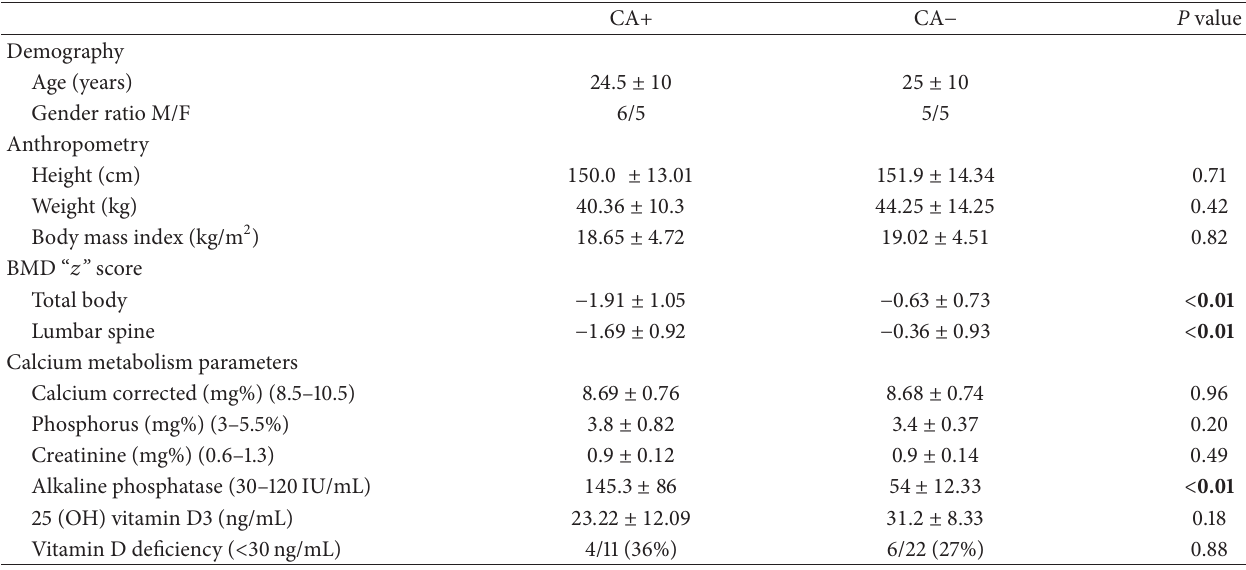
Table 6: Comparison of anthropometry, calcium metabolism parameters, and bone mineral density in CA-positive and negative-T1DM patients (expressed as mean ± SD).